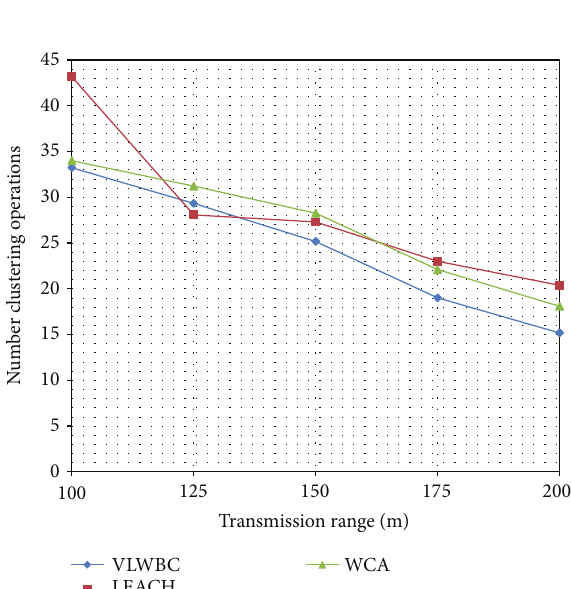
Figure6:Thenumberofclusteringandreclusteringoperationswith different range.